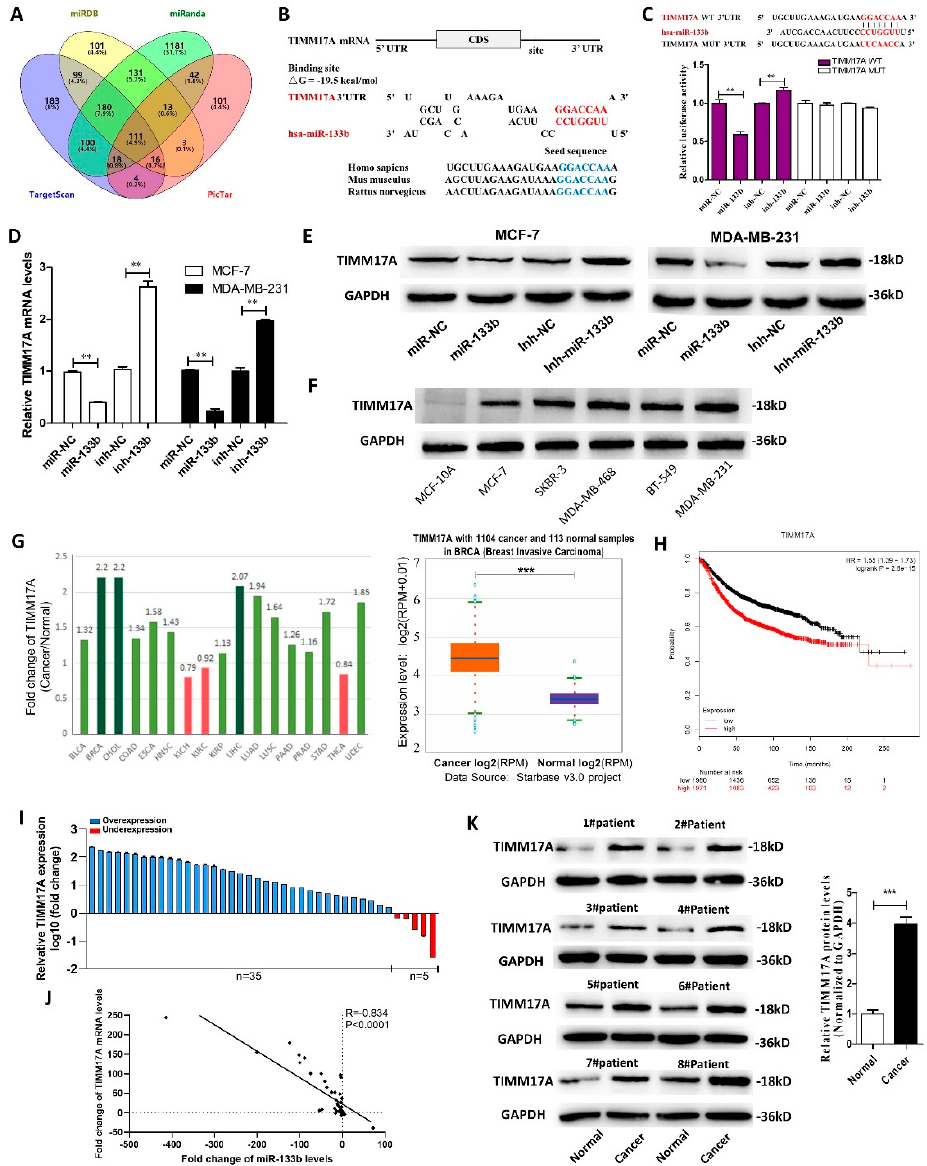
Figure 4. Identification of TIMM17A as a direct target gene of miR-133b in breast cancer cells. ( A ) Venn diagram analysis of four independent databases reveals 111 possible targets of miR-133b. ( B ) Schematic description of the hypothetical duplexes formed by the interactions between the binding sites in the TIMM17A 3 (cid:48) -UTR and miR-133b. The predicted free energy value of the hybrid is indicated. The seed recognition sites are denoted, and all nucleotides in these regions are highly conserved across species, including human, mouse, and rat. ( C ) Luciferase activity in MCF-7 cells co-transfected with a luciferase reporter containing either TIMM17A-WT or TIMM17A-MUT (miR-133b-binding sequence mutated) and mimics NC, miR-133b mimics, inhibitor NC or miR-133b inhibitor. Data are presented as the relative ratio of renilla luciferase activity and firefly luciferase activity. ( D , E ) TIMM17A mRNA ( D ) and protein ( E ) levels in MCF-7 cells and MDA-MB-231 cells transfected with mimics NC, miR-133b mimics, inhibitor NC or miR-133b inhibitor. ( F ) TIMM17A protein levels in di ff erent breast cancer cells and normal breast cells. ( G ) Left: Foldchange of miR-133b in 17 types of cancer tissues compared to their adjacent normal tissues. Right: miR-133b levels in 1104 breast cancer tissues and 113 normal breast tissues in starBase public database from the TCGA project. ( H ) Overall survival analysis of breast cancer patients based on TIMM17A expression ( n = 3951, log-rank test). Data was analyzed using Kaplan Meier Plotter (www.kmplot.com). ( I , J ) TIMM17A mRNA levels ( I )